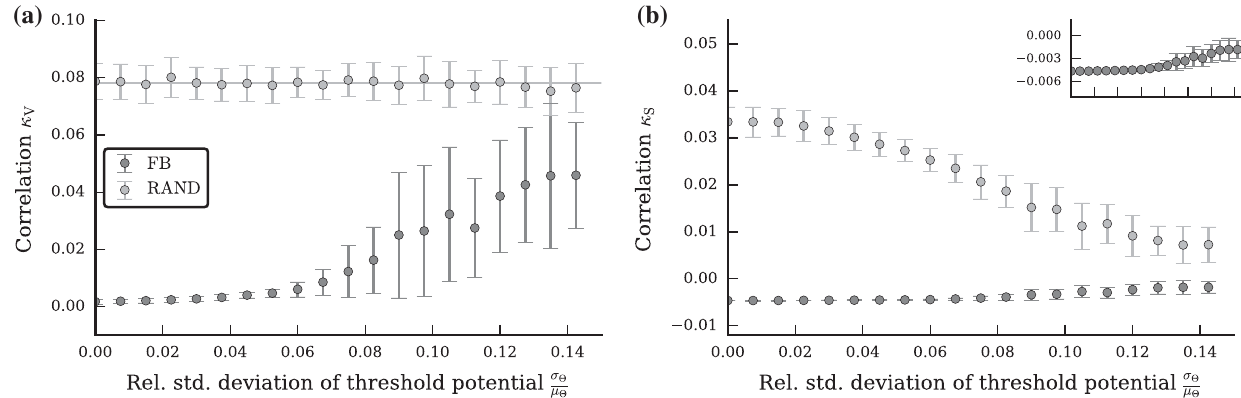
FIG. 9. Dependence of population-averaged input correlations (a) and spike-train correlations (b) on the width of threshold distributions in networks simulated with NEST [101] and PyNN [88], for the intact network (FB, dark gray circles) and the RAND (light gray circles) case. Symbols and error bars denote mean and standard deviation, respectively, across M ¼ 30 network realizations (error bars are partly covered by markers). The gray line in (a) depicts shared-input correlations in a homogeneous network [Eq. (2)]. The inset in (b) shows a magnified view of the spike-train correlations in the FB case. Note that in simulations the FB case, and is hence not shown. For details, see Supplemental Material, Sec. IV